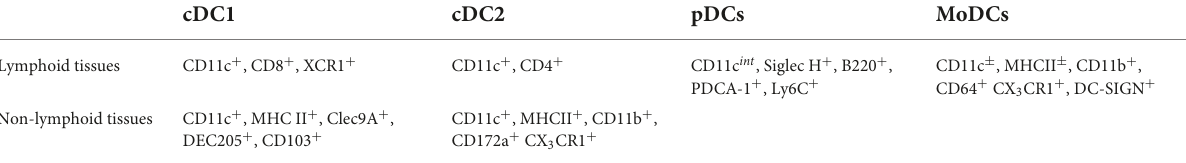
TABLE 1 Key markers of DCs subsets in lymphoid and non-lymphoid tissues. cDC1 cDC2 pDCs MoDCs Lymphoid